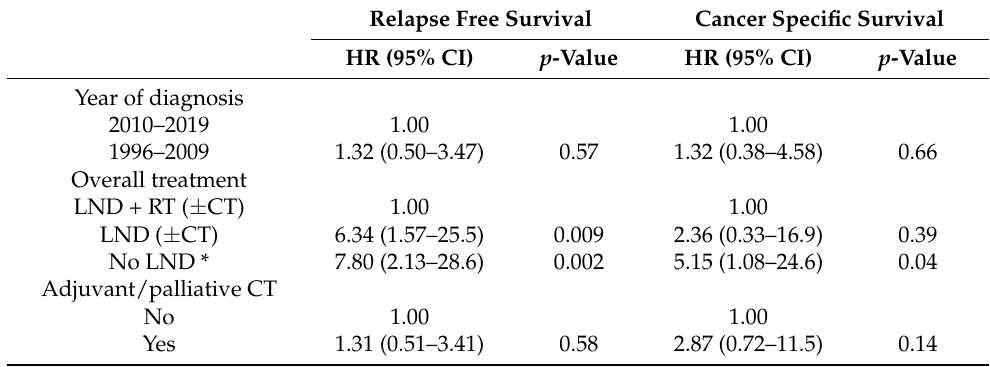
Table 4. Multivariable